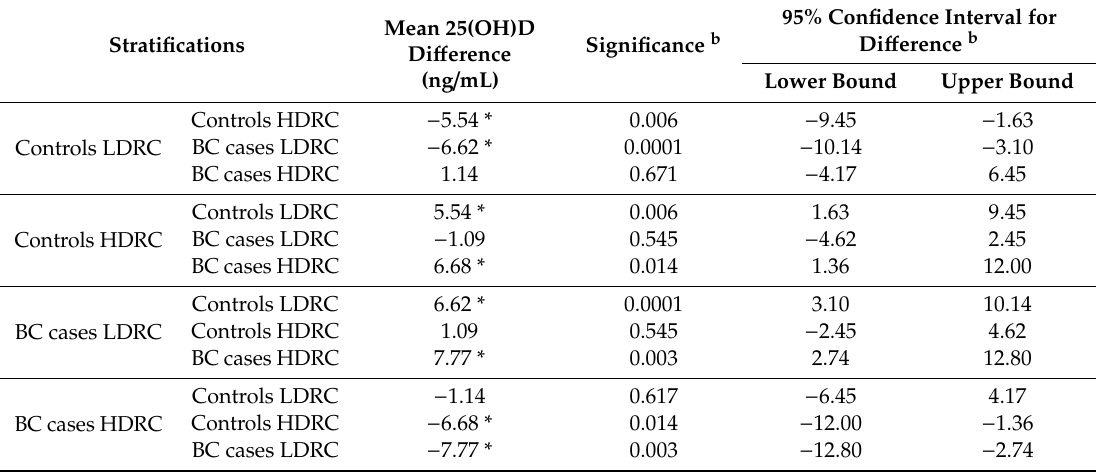
Table 3. Di ff erences in mean 25(OH)D levels among women with and without breast cancer with low and high DNA repair capacity.